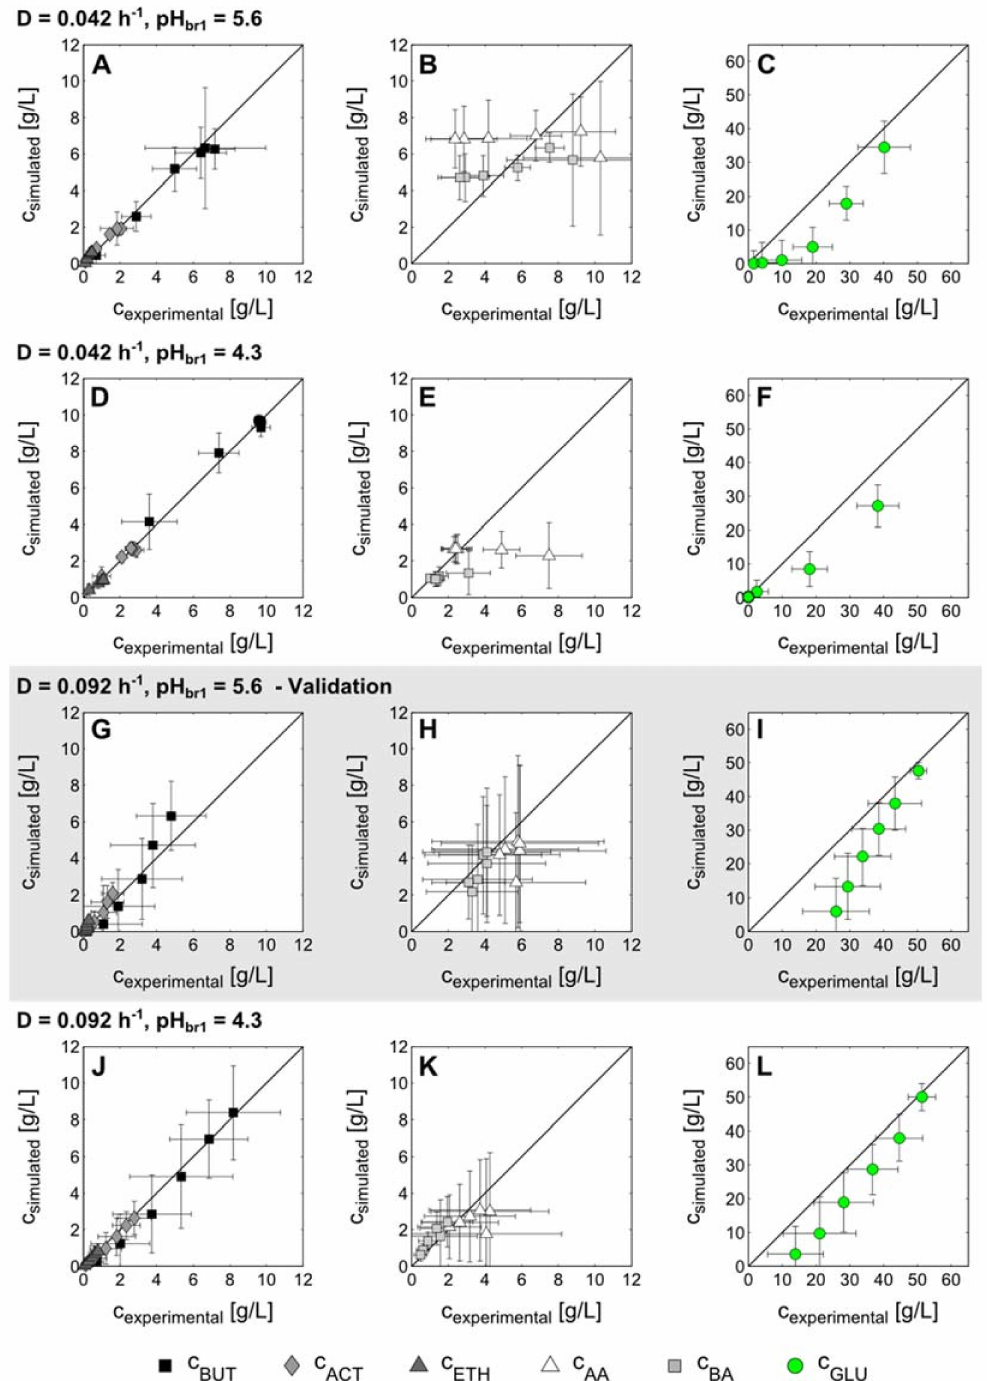
Figure 4. Comparison of experimental and simulated data with respect to the experimental variations. Data sets D = 0.042 h − 1 /pH br1 = 5.6 ( A – C ), D = 0.042 h − 1 /pH br1 = 4.3 ( D – F ) and D = 0.092 h − 1 /pH br1 = 4.3 ( J – L ) were used for parameter optimization. Data set of D = 0.092 h − 1 /pH br1 = 5.6 ( G – I ) was used for validation of the optimized parameter